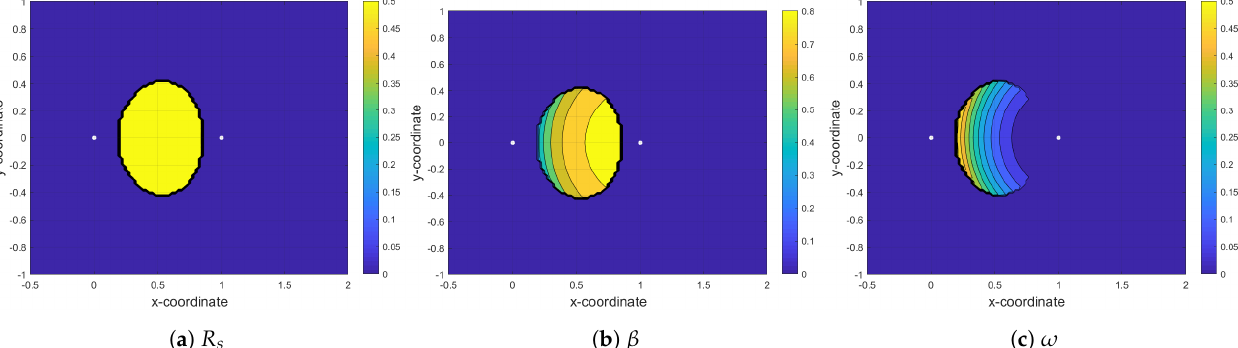
Figure 7. Maximizing rate at the second receiver (SR) by finding the optimum value for time fraction ( β ) and power fraction ( ω ) in the DF-NOMA